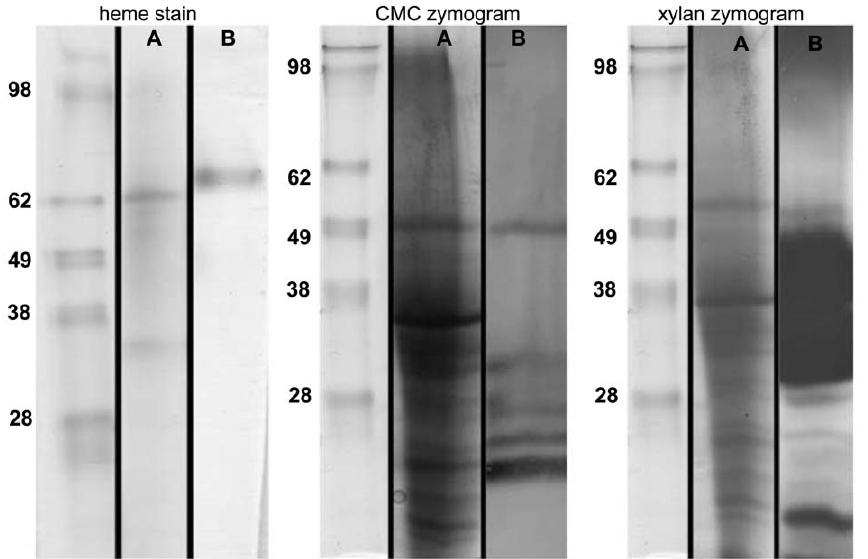
Figure 2. Heme staining and zymogram analysis of A.glabripennis derived F.solani solid wood culture extract. Twenty m g of fungal extract were loaded into each lane. Protein standard is on the left, with band sizes labeled (kDa). Lane A is a colloidal blue stained lane, and lane B is the corresponding heme stain/CMC/or xylan zymogram lane. For heme stain, a single band is present at approximately 70 kDa. For CMC zymogram six major zones of clearing are present at approximately 55, 32, 30, 27, 23 and 20 kDa and can be matched to protein bands on the colloidal blue stained lane. For birch wood xylan zymogram, many zones of clearing are present on the gel with major spots between 30 and 50 kDa. These correspond to a broad range of bands on the colloidal blue stained lane.